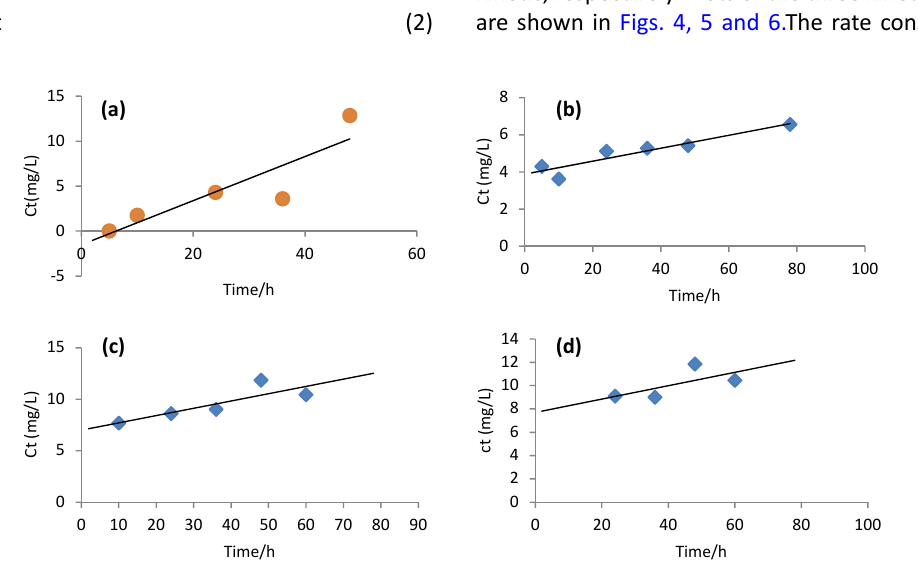
Fig. 4: Zero order kinetic plot at different dye concentrations: (a) 25 mg/L, (b) 100 mg/L, (c) 200 mg/L and (d) 500 mg/L